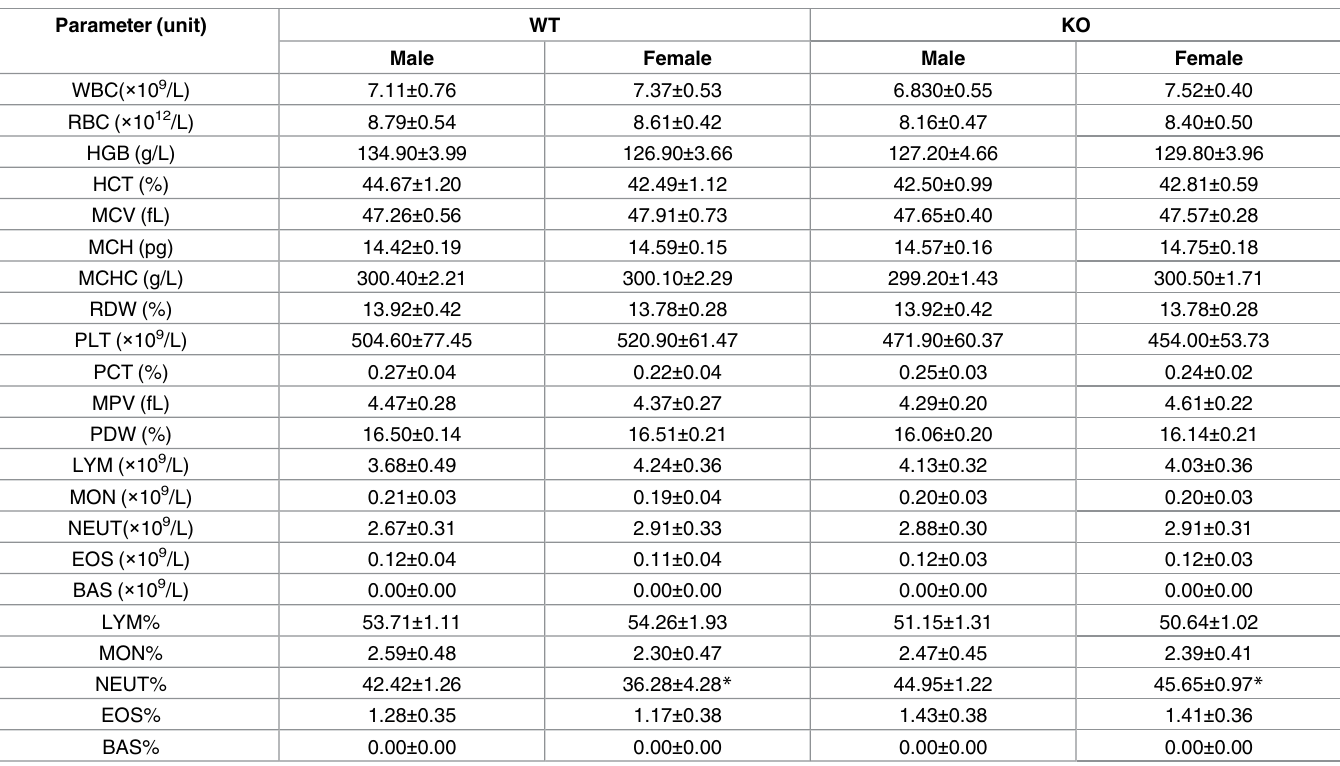
Table 5. Blood physiological values of the control and model groups. Parameter